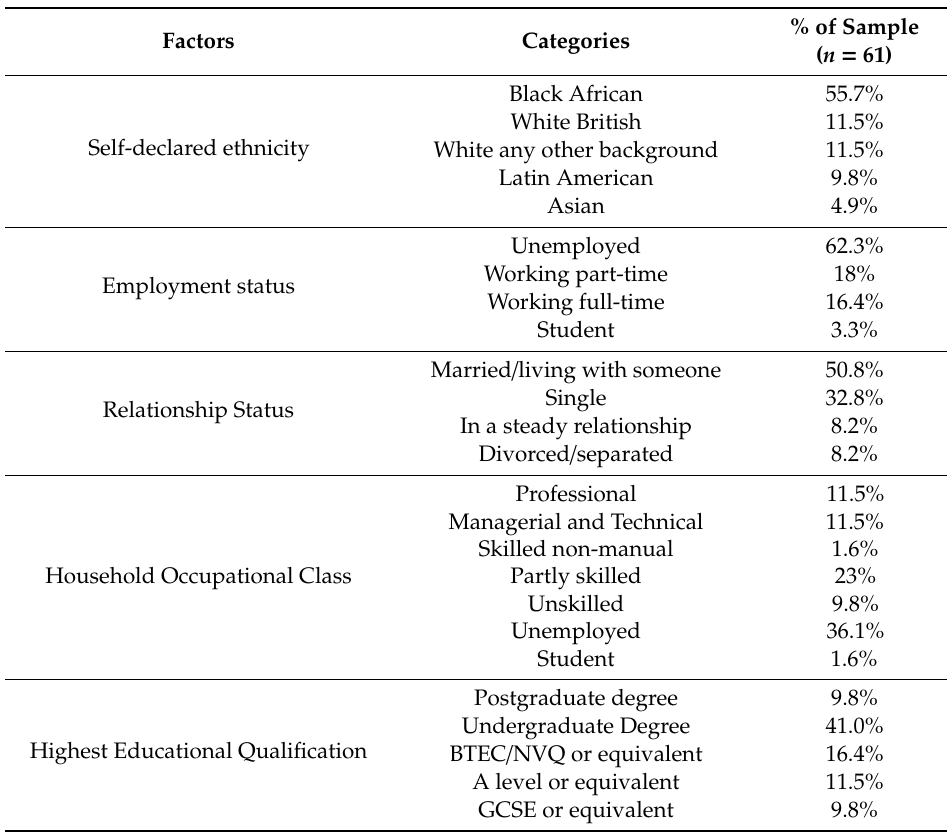
Table 1. Self-declared sociodemographic details of mothers in the Parents and Communities Together (PACT) evaluation study ( n =